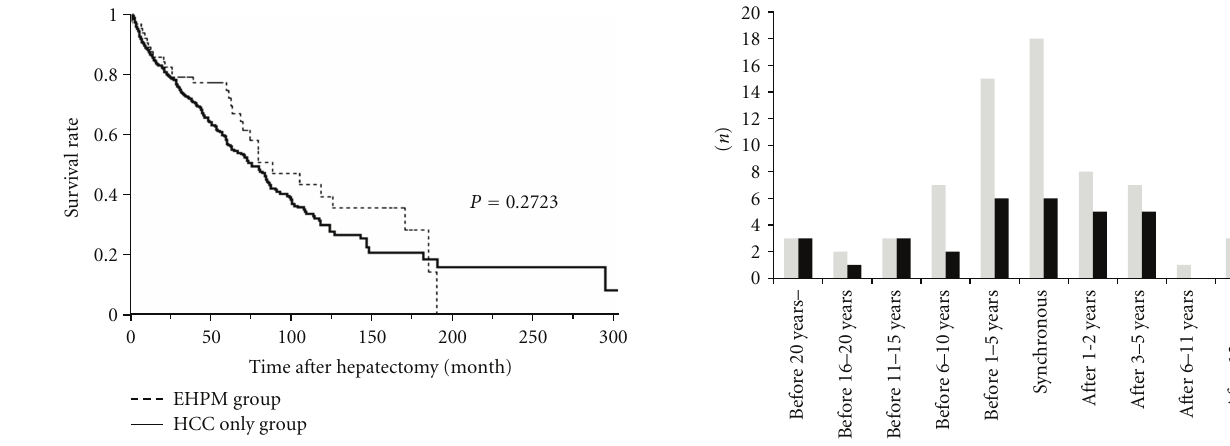
Figure 1: Comparison of Kaplan-Meier curves in HCC-only and EHPM groups. No significant di ff erence was observed in overall survival between the groups (log-rank test, P = 0 . 2723).